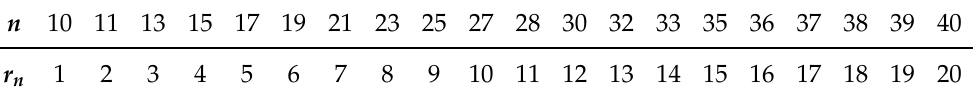
Table 3. Stopping boundaries of the modified version of the design by Lee and Liu [11], when N =